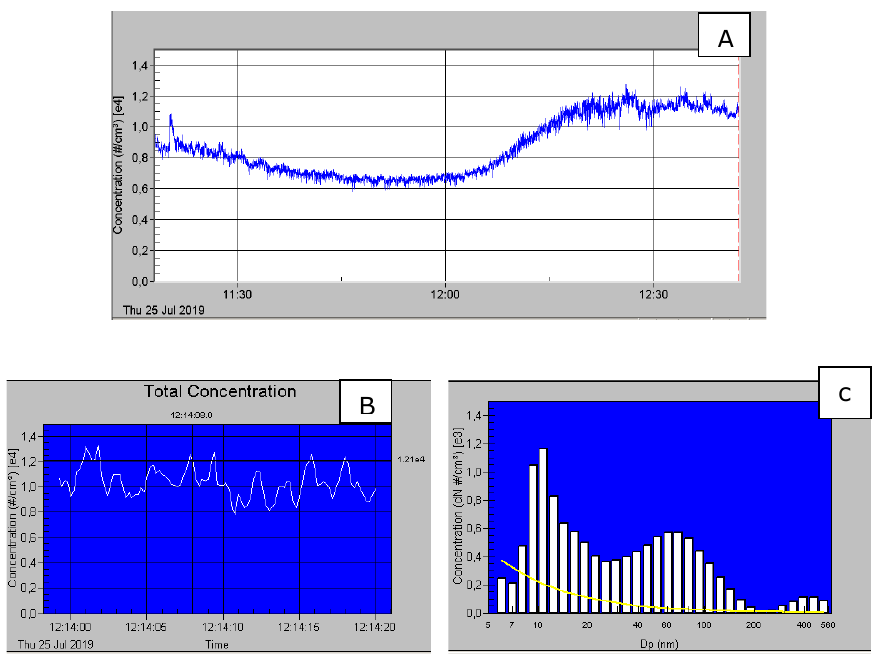
Figure 9 . Nanoparticles during ABS printing. A (CPC concentration), B (EEPS concentration), C (EEPS size distribution) The mass concentration levels measured with the side-pak AM510 were all less than